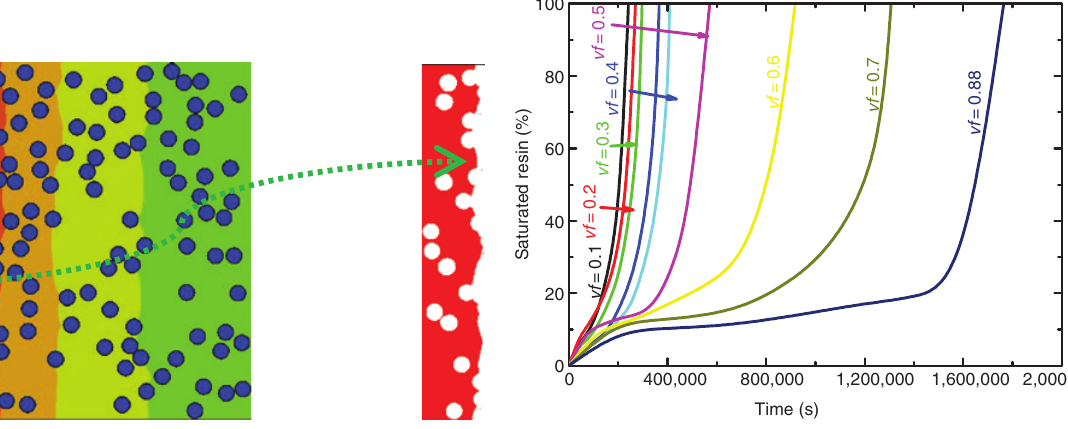
Figure 18: Fraction of saturated epoxy phase at different time points for different volume